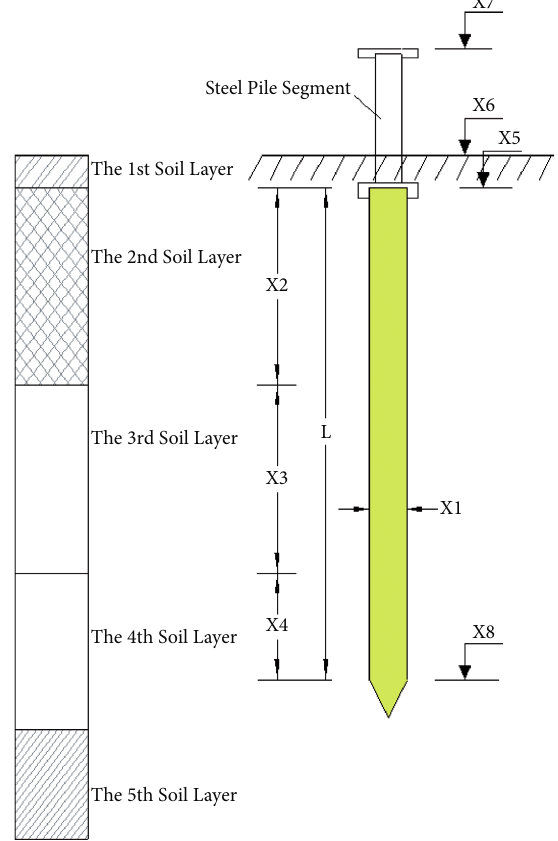
Figure 2: Demonstration of the pile structure and soil